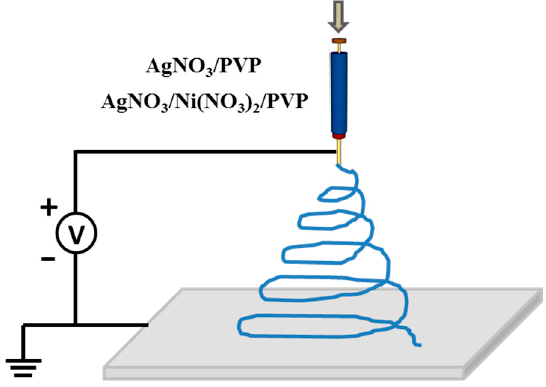
Figure 2. Illustration of electrospinning process.